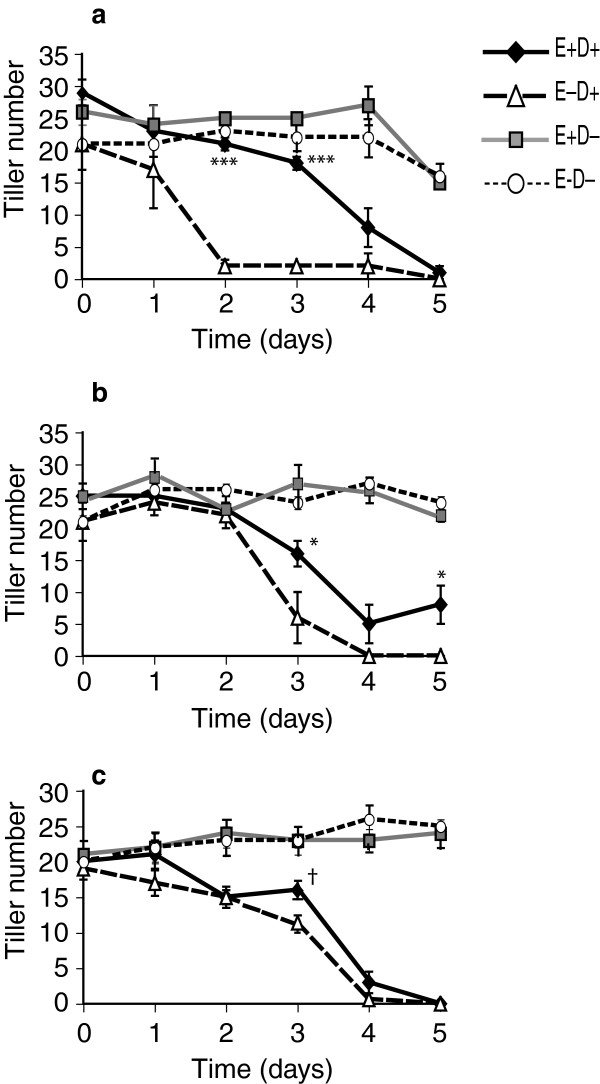
Tiller recovery from water-deficit stressed E+ and E- plants after placing them back into normal watering regime. (a) First clone pair 278 (E+)/279 (E-), Experiment 1, error bars are SEM (n = 4); (b) First clone pair 278 (E+)/279 (E-), Experiment 2, error bars are SEM (n = 5); (c) Second clone pair 4607(E+)/4608 (E-), error bars are SEM (n = 5). E+ D+ = endophyte infected and water withheld for the time periods indicated; E-D + = endophyte uninfected and water withheld; E+ D- = endophyte infected and unstressed; E-D- = endophyte uninfected and unstressed. Symbols indicating statistical significance based on t-max are ‘***’ p < 0.001; ‘**’ p > 0.001 - 0.01; ‘*’p > 0.01 - 0.1; ‘†’ p = 0.110 based on t-max; p = 0.019 based on t values).